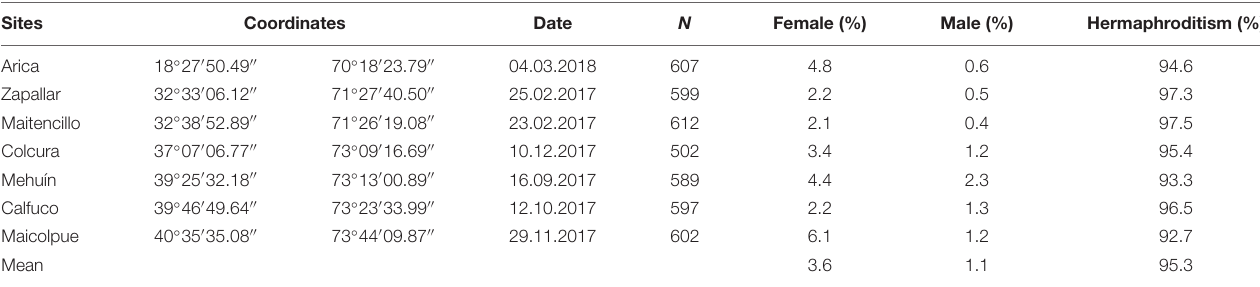
TABLE 1 | Site survey information in Chile, number of Semimytilus algosus specimens collected ( N ), date of collection, geographical coordinates of sites and percentage of males, females and hermaphrodites. Sites